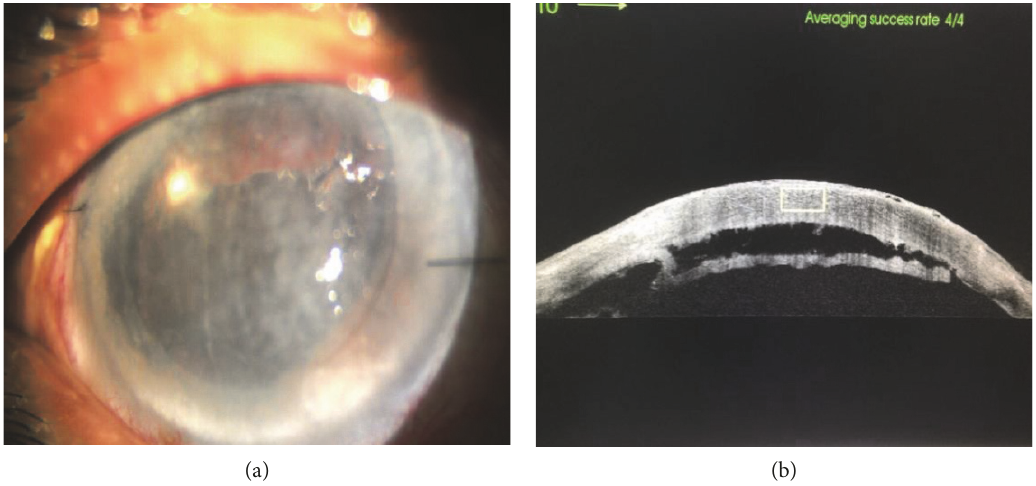
Figure 6: (a) Double anterior chamber in one patient. (b) OCT of the same